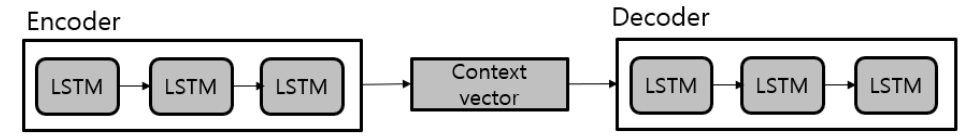
Figure 5. The structure of Seq2Seq.